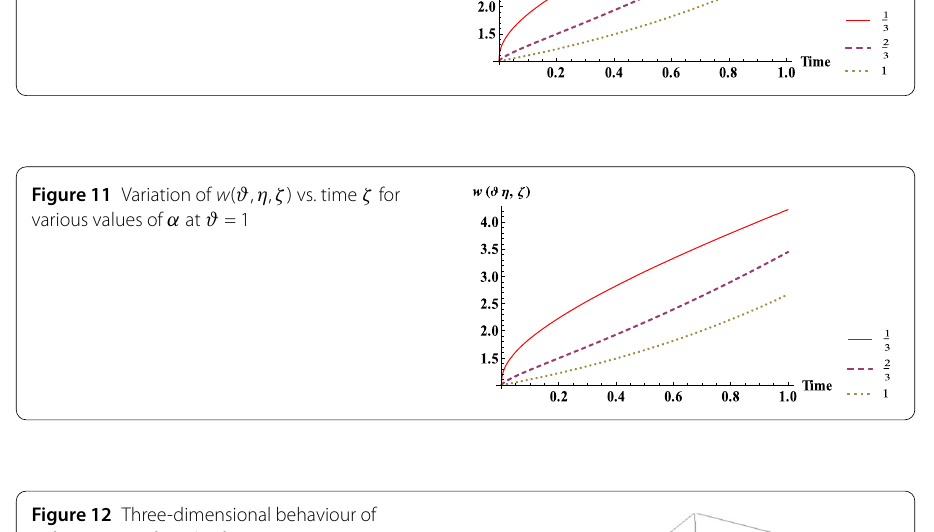
Figure 10 Variation of v ( ϑ , η , ζ ) vs. time ζ for various values of α at ϑ = 1